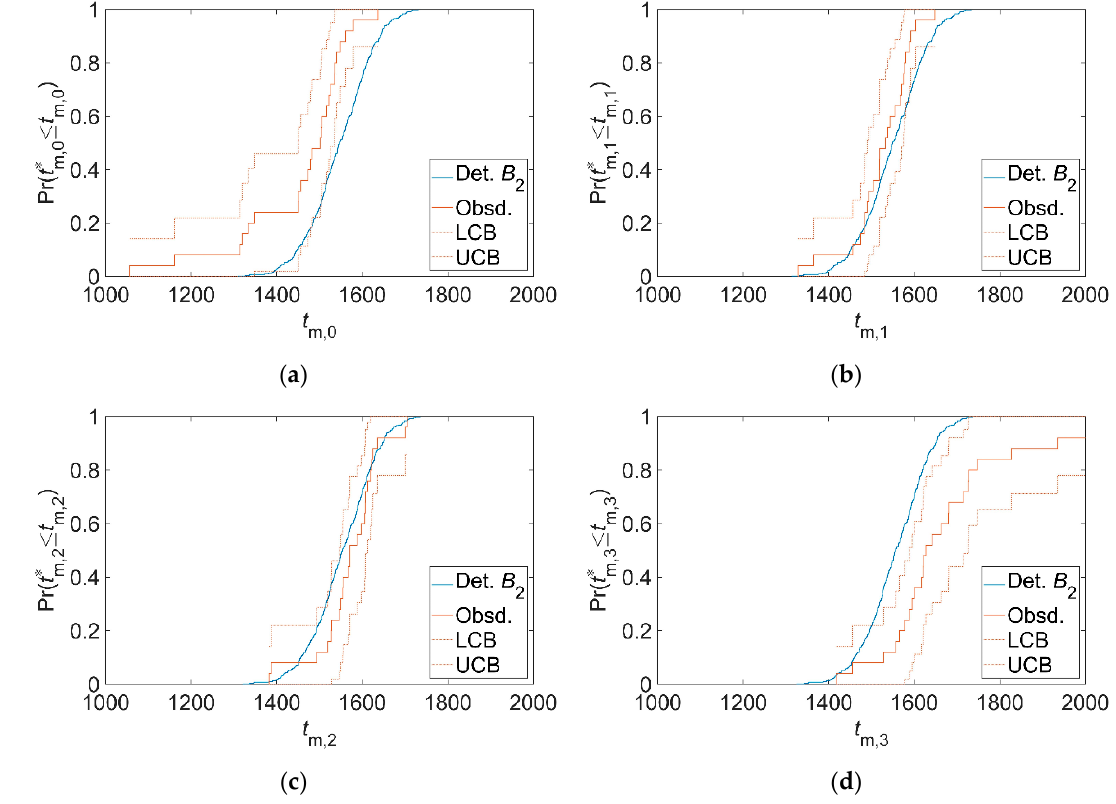
Figure 9. The simulated and observed cumulative distribution functions of the latent periods for the deterministic secondary nucleation: ( a ) at j’ = 0, ( b ) at j’ = 1, ( c ) at j’ = 2, and ( d ) at j’ = 3. The simulated ones for the deterministic secondary nucleation (Det B 2 ) are denoted by the blue solid lines.